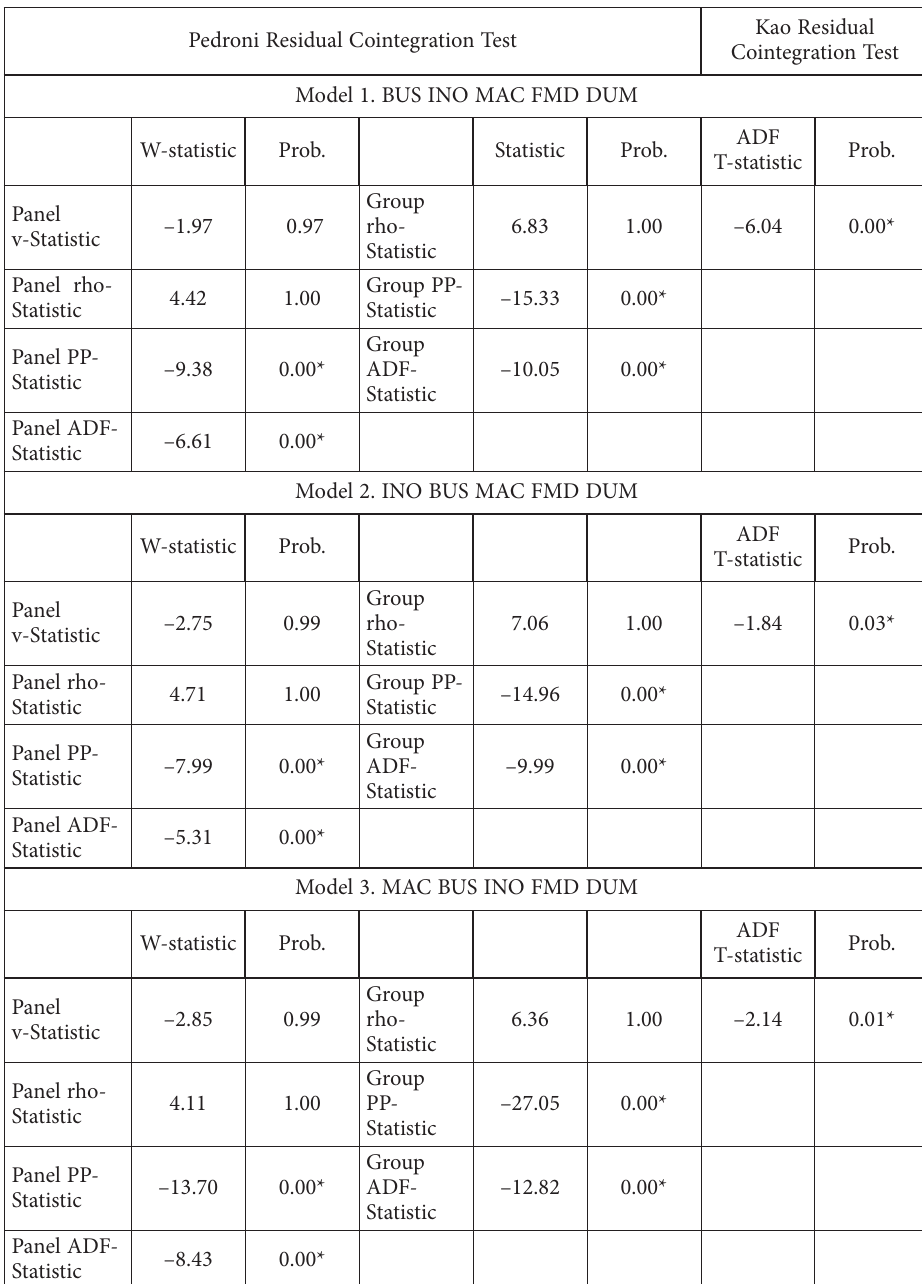
Table 3. Panel Cointegration Test (source: author’s